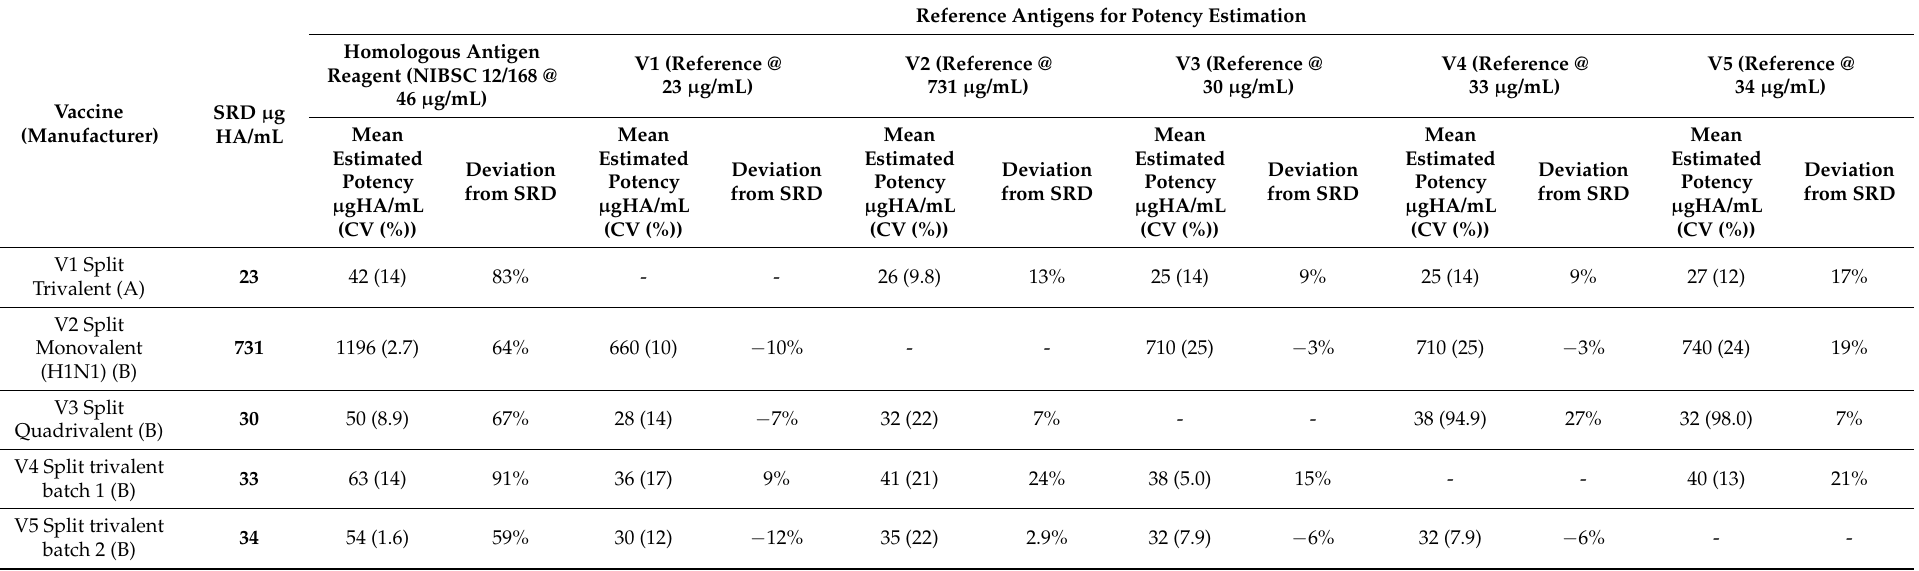
Table 4. Potency estimates of vaccine samples by sandwich